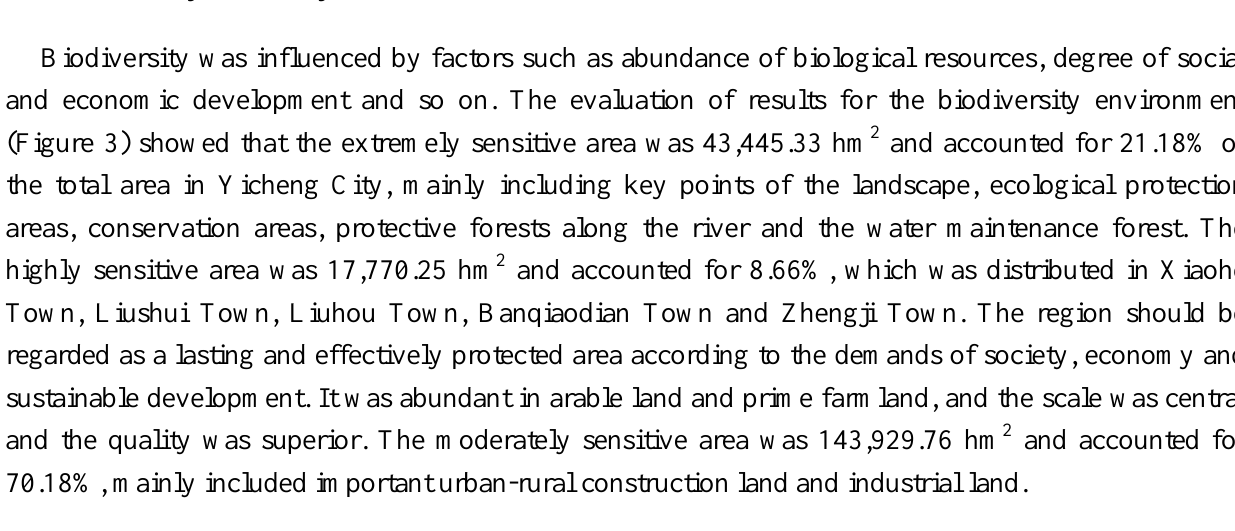
Table 4. Biodiversity sensitivity evaluation results for Yicheng